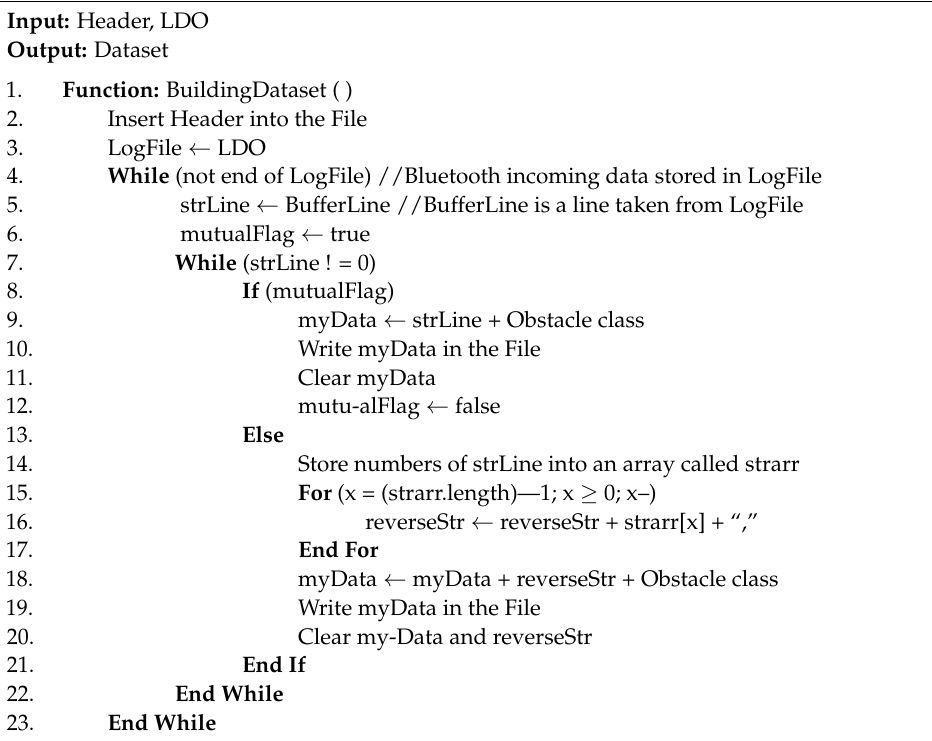
Algorithm 3 outlines how our system’s dataset is created. It takes the CSV Header, LDO, and Features as inputs. Using the Building Dataset function, the CSV header file from CSVHeader is first placed in the new dataset, CSVFile. Data are collected from LDO and saved in a LogFile using the DataCollection method. LDO represents the LiDAR distance readings, while the loop records the data in the proper format, saving the LiDAR downwards data in the original order and reversing the order of the LiDAR upward data. Algorithm 3 : DatasetModule: Building Dataset